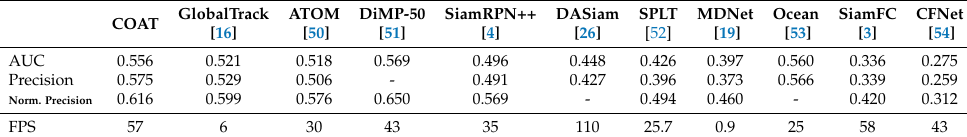
Table 1. Quantitative comparison on the LaSOT test set.